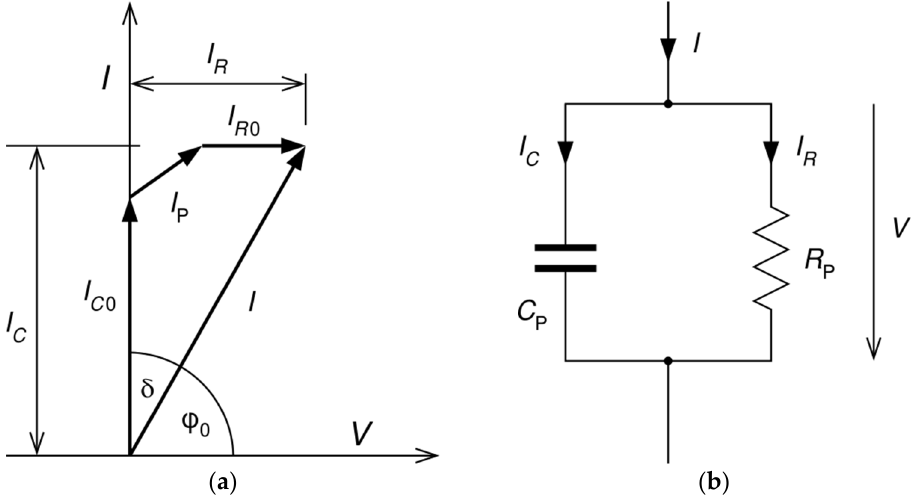
Figure 6. Dielectric loss factor: ( a ) vector diagram; ( b ) simplified equivalent circuit. Measurement results in Figure 7 show that the dielectric loss factor increases with increasing relative humidity. It is clear from Figure 7 that with the increase in pollution levels, the dielectric loss factor increases. The frequency response of the dielectric